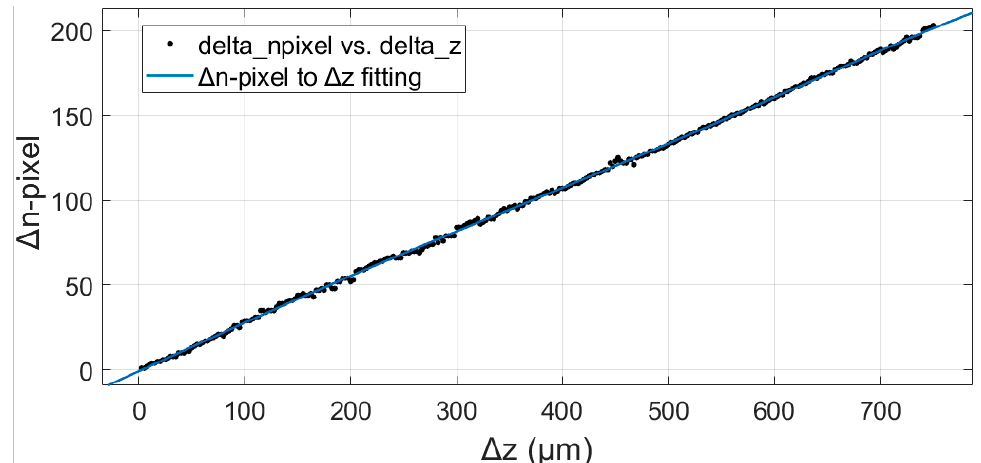
Figure 4. Sensors 2020 , 20 , x FOR PEER REVIEW